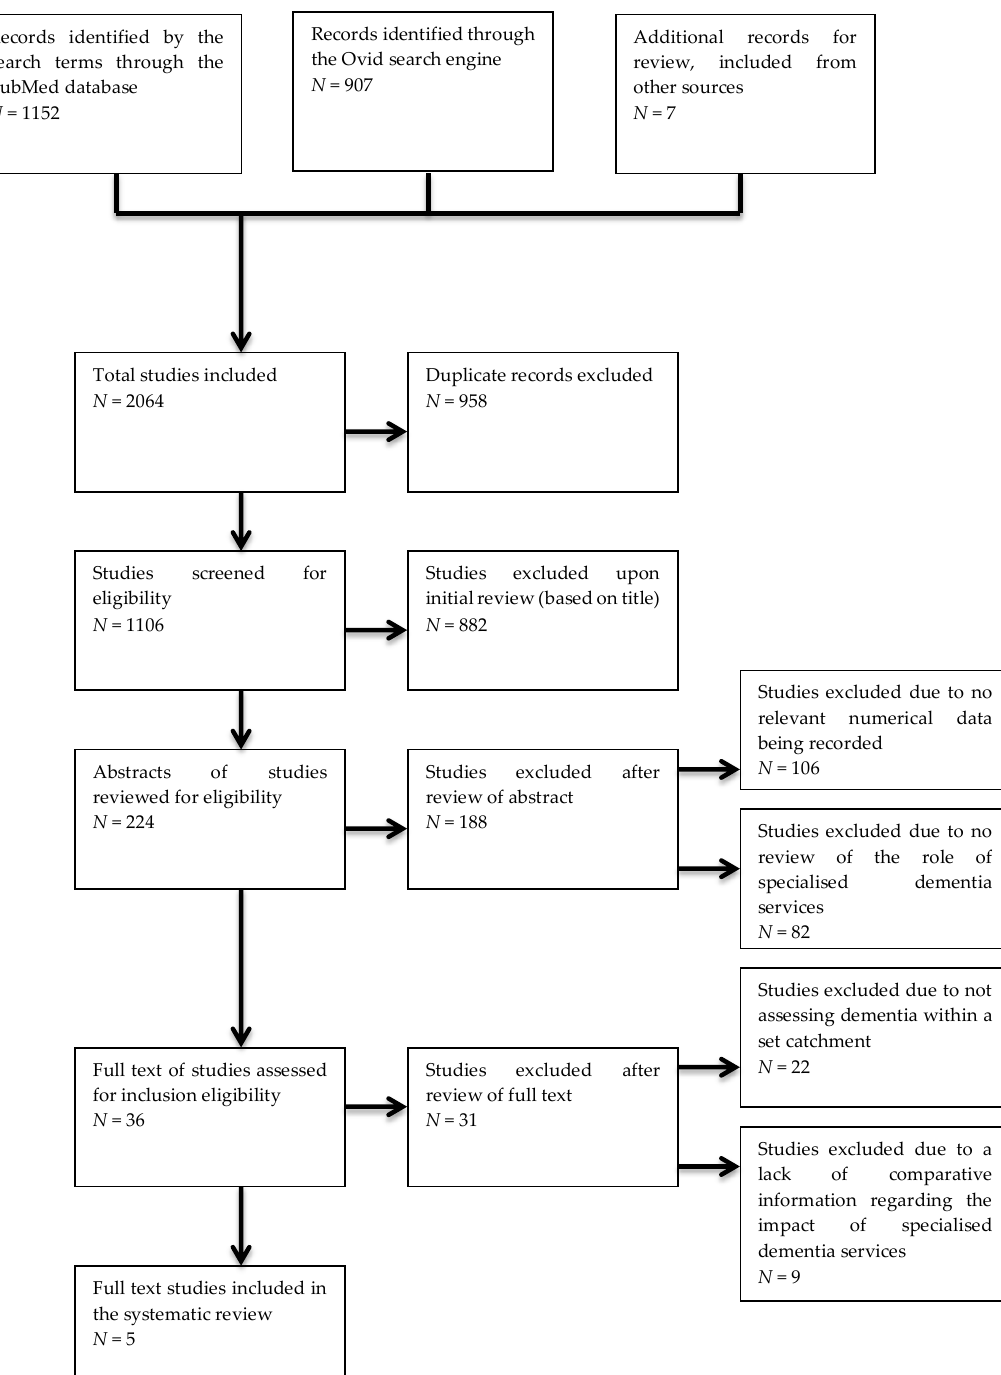
Figure 1. Flow diagram of the studies identified and assessed through the eligibility and inclusion criteria.